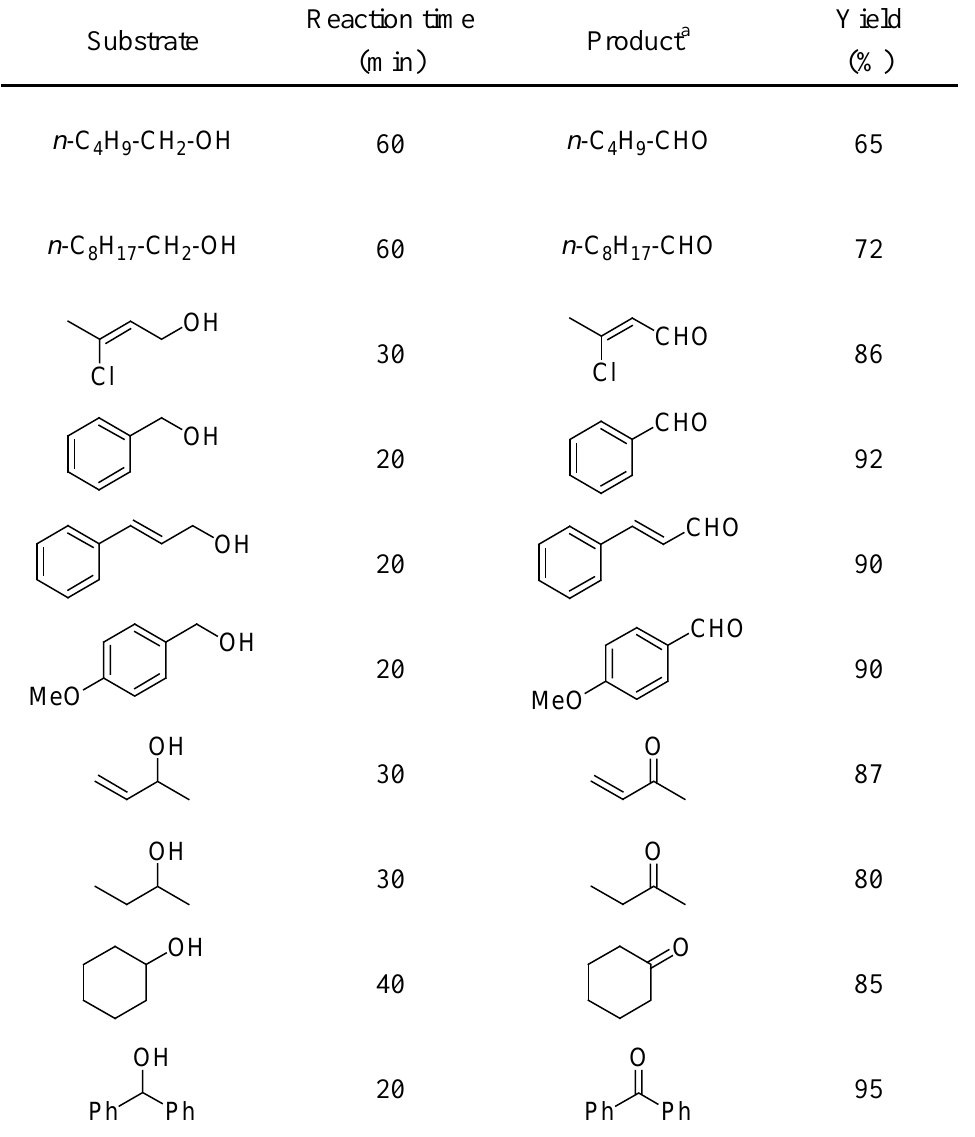
Solvent free oxidation of alcohols with CrO Reaction time Substrate